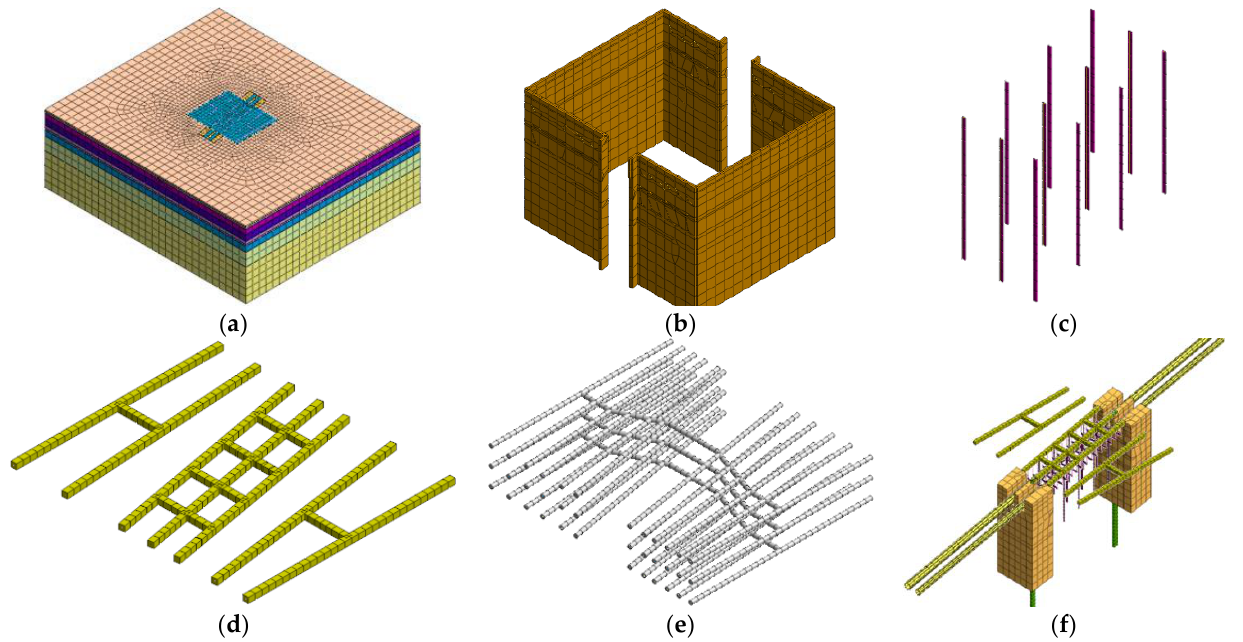
Figure 6. Meshing of the finite element analysis model: ( a ) Overall model; ( b ) Diaphragm walls; ( c ) Lattice columns; ( d ) Concrete struts; ( e ) Steel struts; ( f ) Pipeline suspension structure.